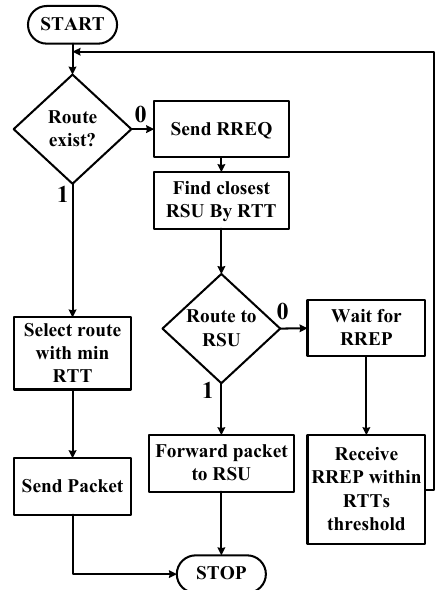
Figure 1. Flow diagram of message handling.